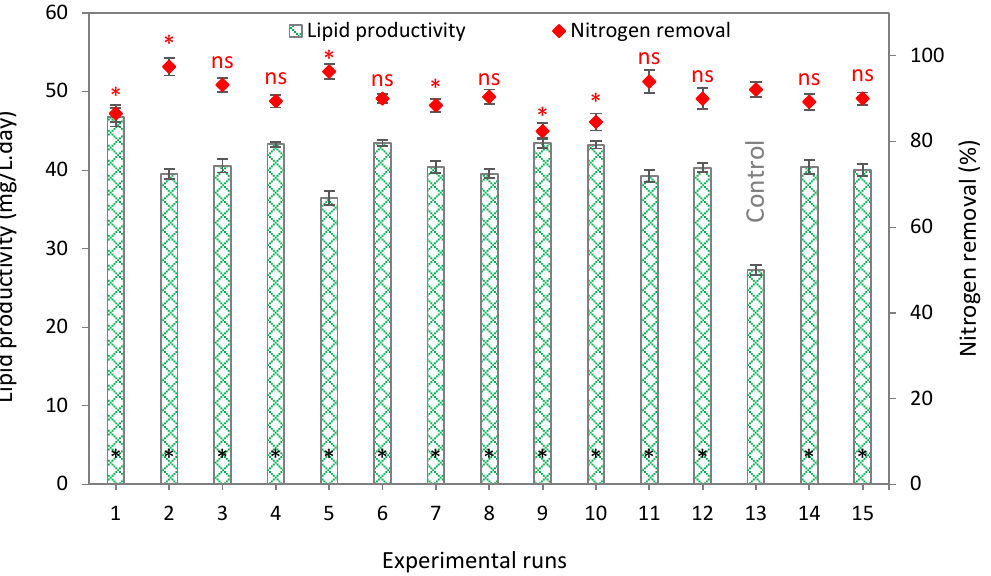
Figure 4. Lipid productivity and nitrogen removal by Chlorella sp. cultivated at different sodium nitrate concentrations, seawater ratios, and glycerol supplementation using randomized central composite design as shown in Table S1. * and ns represent significant and non-significant differences, respectively, with respect to the control (Run #13) at p ≤ 0.05.